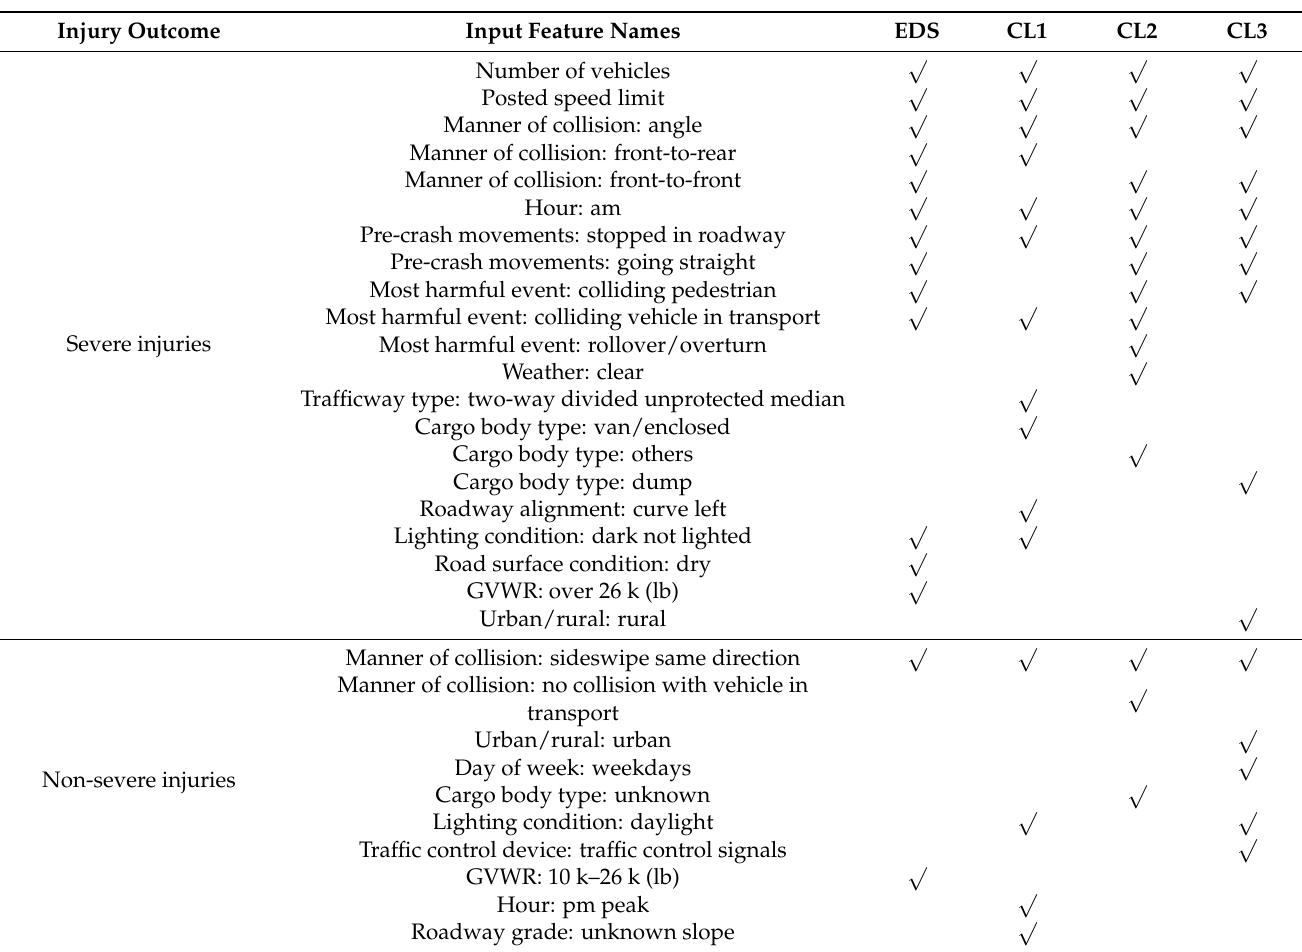
Table 7. Important common and unique features in the EDS and